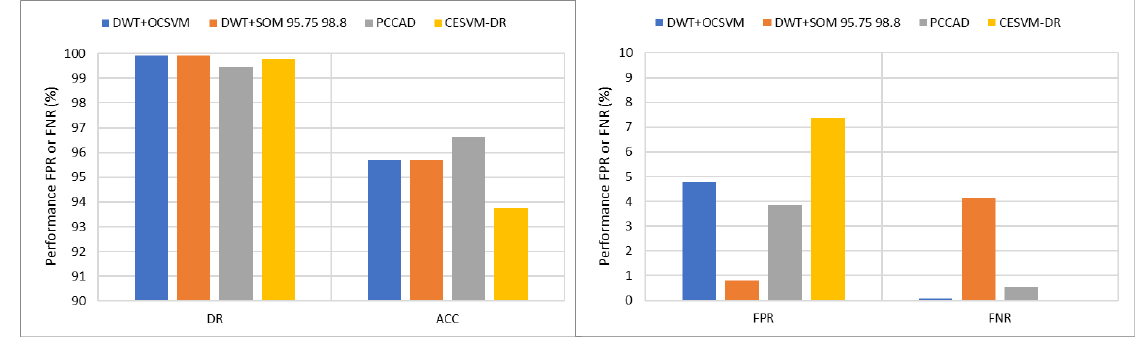
Figure 7. Average Performance Comparisons Accuracy and DR ( left ) while FPR and FNR ( right ). Table 3. The Comparison Proposed of Effectiveness Evaluation with Other Related Anomaly Detection Schemes Using Histogram-Based Labelling.